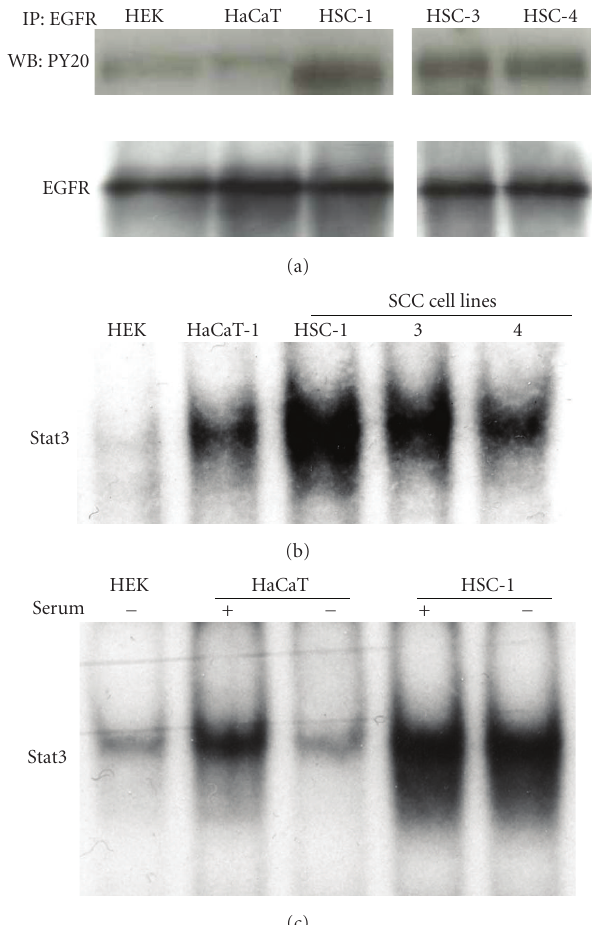
Figure 3: Analysis of EGFR and Stat3 activation in human epidermal primary keratinocytes (HEK), HaCaT cells, and human SCC cells. Cells were incubated in serum-free medium for 24 hours, and then cell lysates were extracted from HEK, HaCaT cells, HSC-1, -3, or -4 cells. Total 100 μ g of protein in each lysate were subjected to immunoprecipitation (IP) with the anti-EGFR antibody. The immunoprecipitates were separated by SDS-PAGE and subjected to immunoblot analysis with an anti-phosphotyrosine antibody, PY20. The same membrane was then reprobed with the anti-EGFR antibody. Data are representative of three independent experiments (a). Nuclear extracts from HEK, HaCaT cells, HSC-1, -3, or -4 cells under the regular condition were analyzed using EMSA with a 32 P- labeled DNA probe to detect DNA binding activity of Stat3 (b). HSC-1 or HaCaT cells were seeded in medium with 10% fetal calf serum, and the cells were cultured for 24 hours, after which they were cultured in medium with or without 10% fetal calf serum for 24 hours and Stat3 activation was analyzed using EMSA